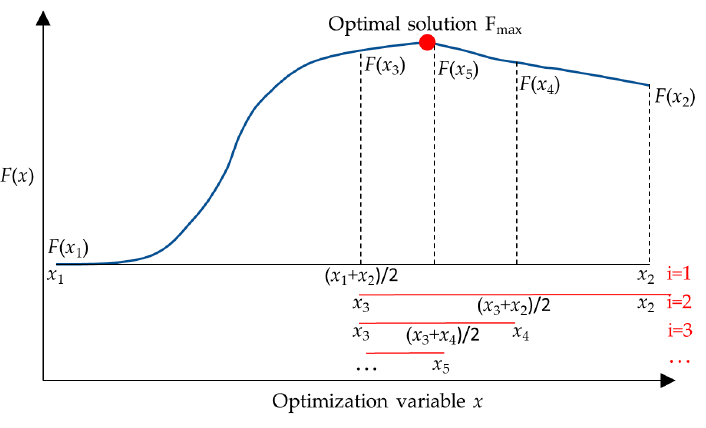
Figure 11. Schematic of the dichotomous search method, where F ( x ) is the objective function.